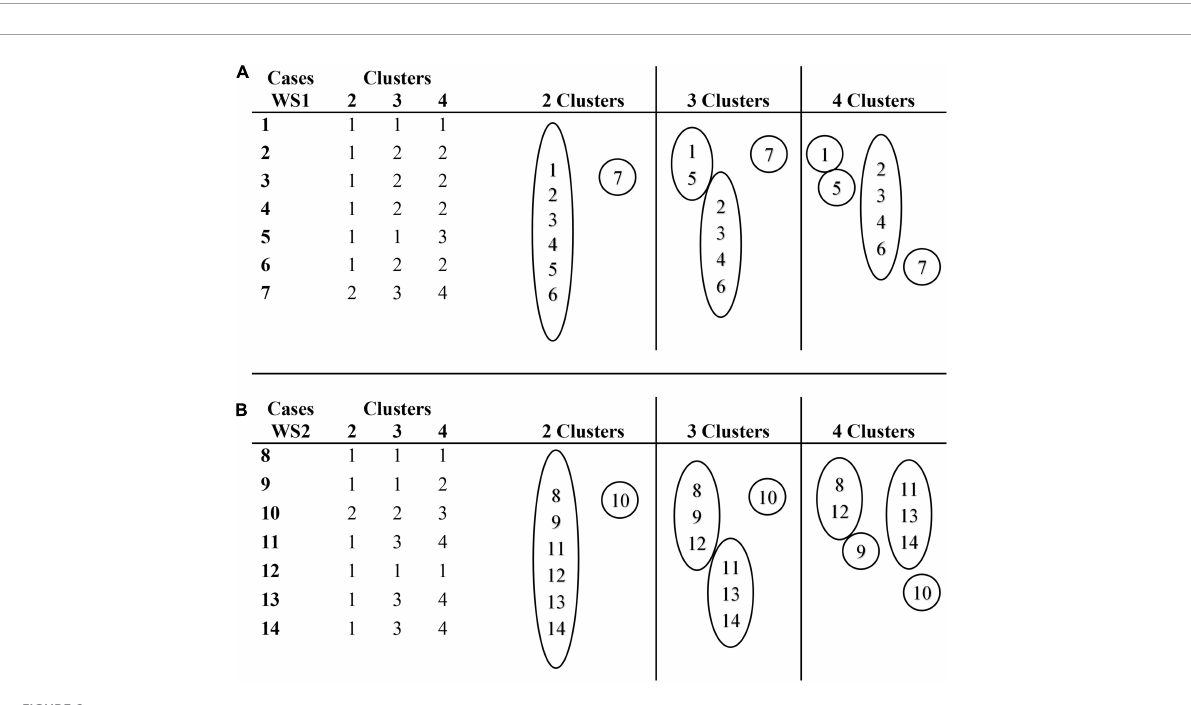
FIGURE6 Cluster membership for a range of solutions (2, 3, and 4 clusters) for syllable structures processes. (A) Cluster membership of cases in WS1 group. (B) Cluster membership of cases in WS2